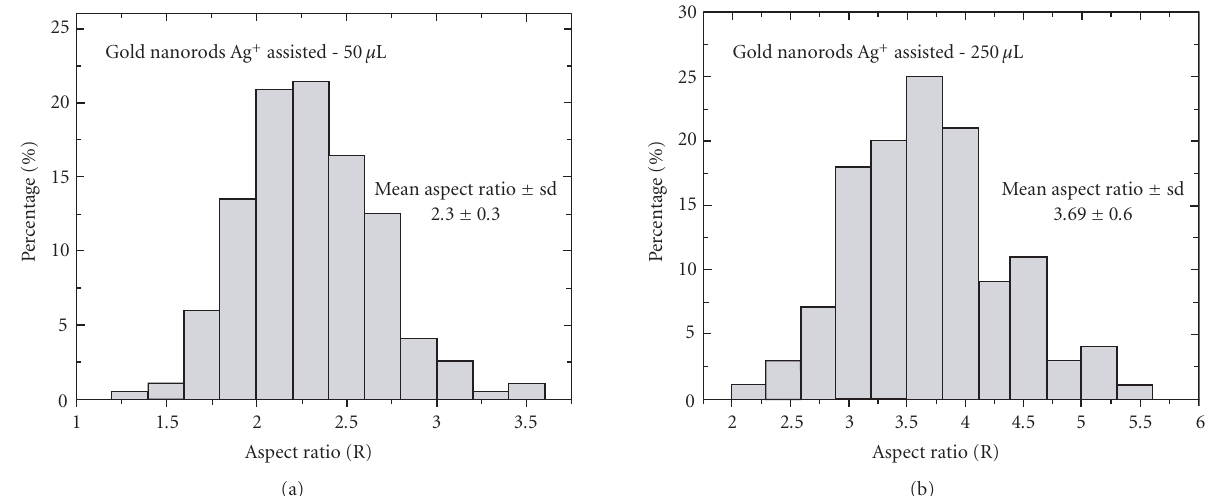
Figure 4: Histograms of gold nanorod aspect ratios synthesized with (a) 50 μ L silver nitrate, mean aspect ratio of 2 . 3 ± 0 . 3 (mean length 44 . 8 ± 4 . 1 nm, mean width 19 . 8 ± 2 . 9nm); and with (b) 250 μ L silver nitrate, mean aspect ratio of 3 . 6 ± 0 . 6 (mean length 51 . 0 ± 4 . 4 nm, mean width 14 . 1 ± 2 . 1).